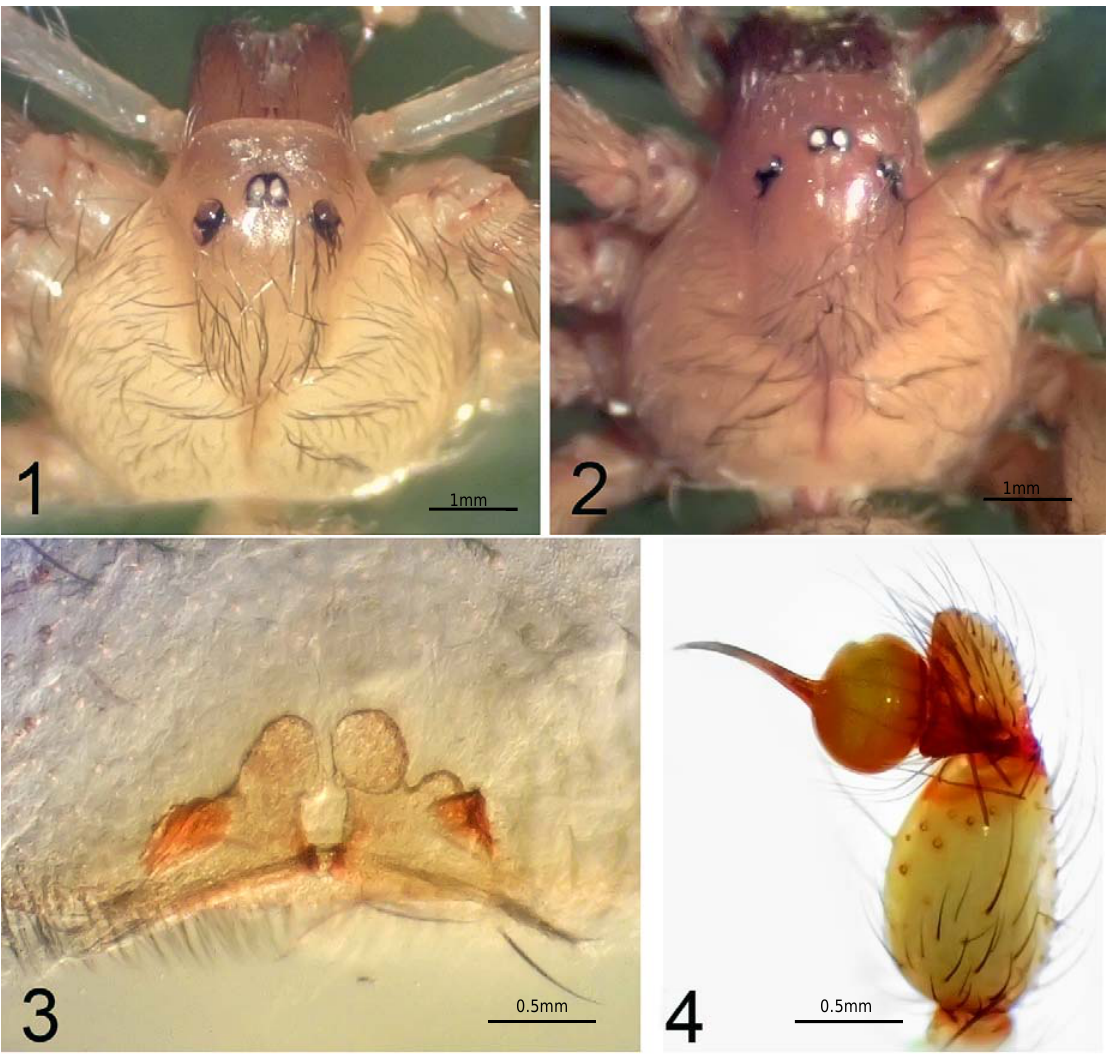
Lateral aspect of right